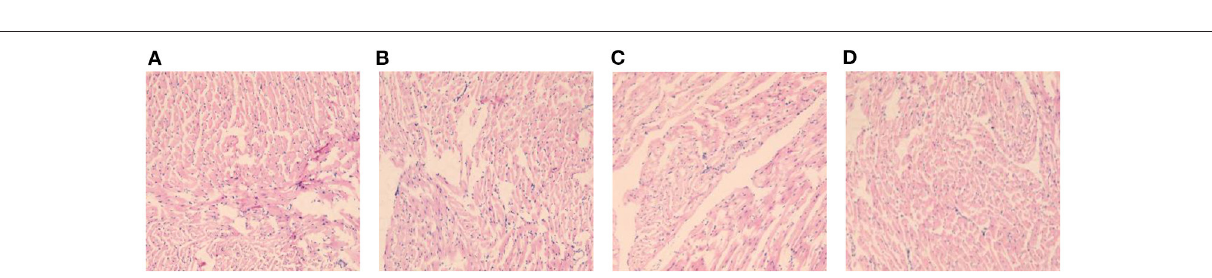
FIGURE 5 | Histomorphological changes of myocardium in each group of rats (HE, × 400). (A) is the DCM group, (B) is the S1 group, (C) is the S2 group, and (D) is the S3